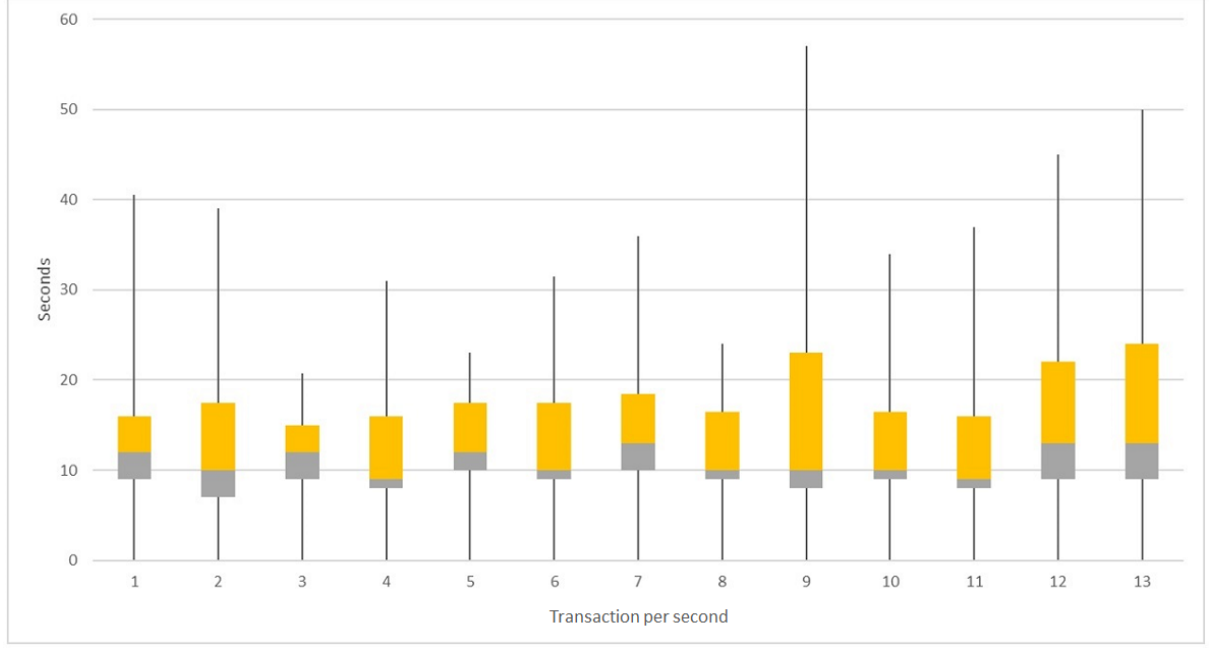
Figure 5. Box plot of simulation results for 1 to 13 transactions per second groups. The boxes show the different quantiles of time cost related to different scales of transactions per